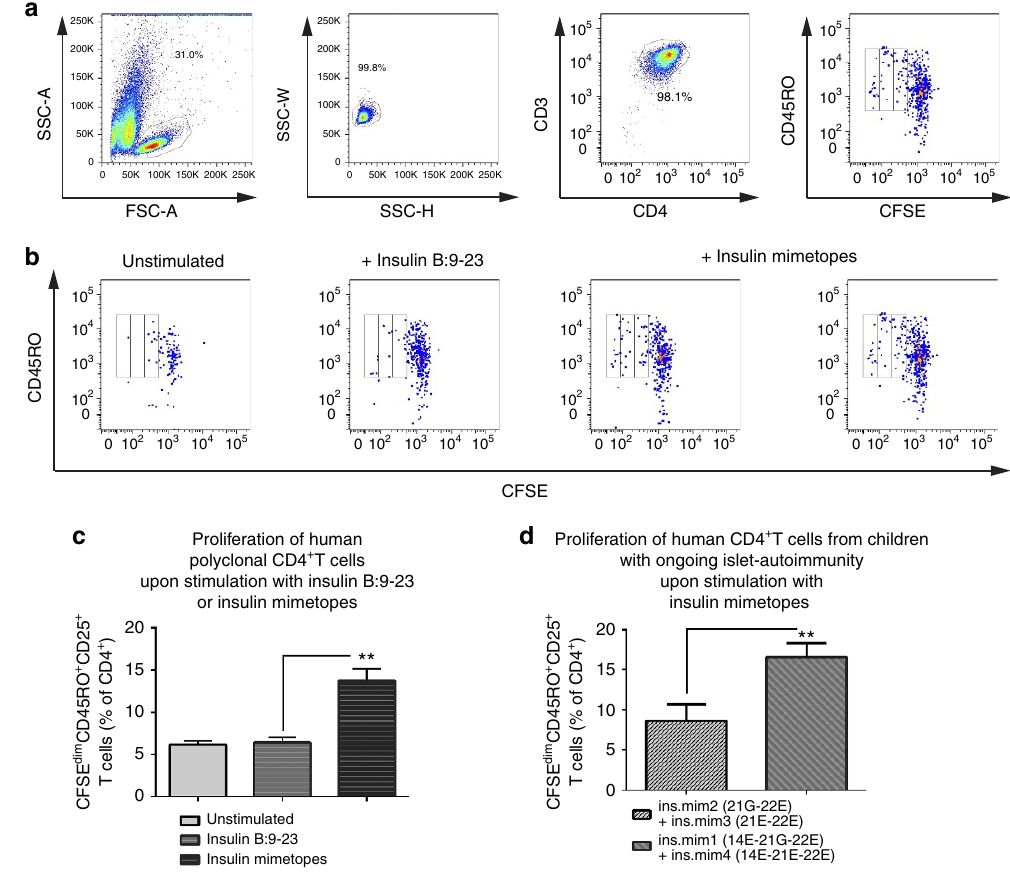
Figure 1 | Agonistic activity of insulin mimetopes in human polyclonal CD4 þ T cells required for Foxp3 þ Treg induction. ( a ) Representative FACS plots for the identification of proliferating human polyclonal CD4 þ CD3 þ T cells by CFSE-dilution in CD45RO þ CD4 þ CD25 þ T cells (left to right). ( b ) Representative FACS plots of CFSE-dilution profiles from human polyclonal CD4 þ T cells purified from children with or without pre-T1D either left untreated, stimulated with the natural insulin B:9-23 epitope (1 m gml (cid:3) 1 ) or a set of four insulin-B-chain-10-23-mimetopes (shown are two staining examples of cells stimulated with ins.mim.2 ¼ 21G-22E; ins.mim.3 ¼ 21E-22E; ins.mim.1 ¼ 14E-21G-22E; ins.mim.4 ¼ 14E-21E-22E, final concentration at 1 m gml (cid:3) 1 ). Proliferating CFSE dim CD4 þ CD25 þ CD45RO þ T cells were considered as responding T cells. ( c ) Percentages of divided human CFSE dim CD4 þ CD25 þ CD45RO þ T cells. Bars represent the means ± s.e.m. ( n ¼ 8) from duplicate wells of eight children performed in four independent experiments. ** P o 0.01 (Student´s t -test). ( d ) Percentages of divided human CFSE dim CD4 þ CD45RO þ T cells upon stimulation with a combination of ins.mim.2 ¼ 21G-22E; ins.mim.3 ¼ 21E-22E or a combination of ins.mim.1 ¼ 14E-21G-22E; ins.mim.4 ¼ 14E-21E-22E. Bars represent the means ± s.e.m. ( n ¼ 6) from duplicate wells of six children done in three independent experiments. ** P o 0.01 (Student´s t